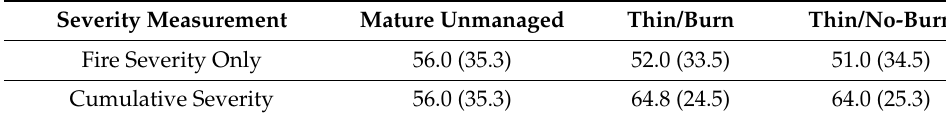
Table 1. Fire severity (Caldor Fire only) and cumulative severity (mortality from commercial thinning and Caldor Fire), in terms of mean percent basal area mortality (and s.d.), for mature unmanaged forests ( n = 100), commercial thinning with slash burning ( n = 100), and commercial thinning with no slash burning ( n = 100) in the Caldor Fire of 2021.